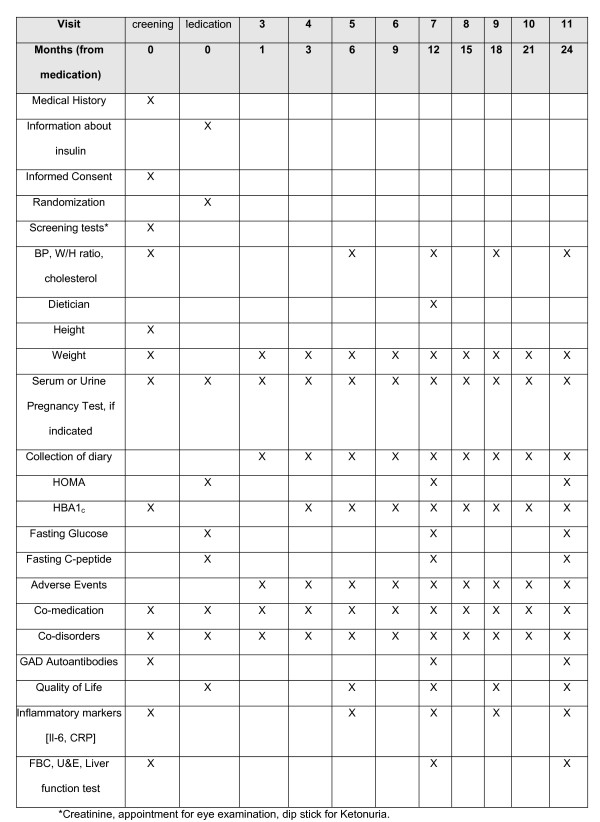
Schedule of visits.